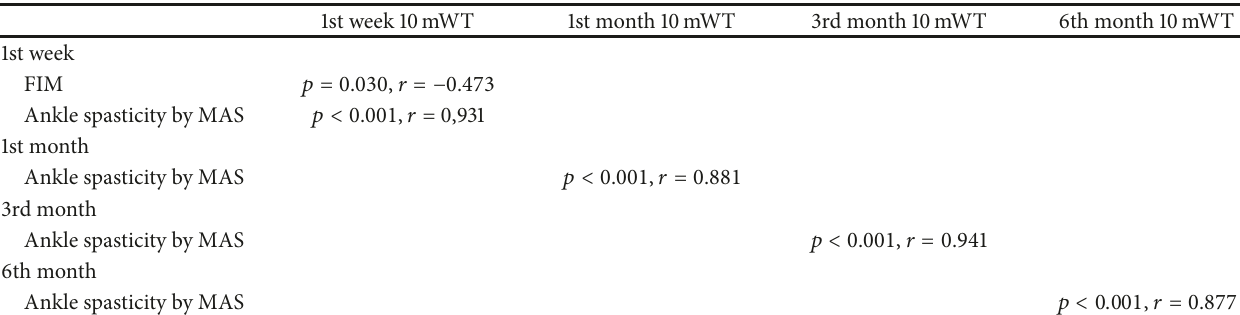
Table 3: Correlations between 10mWT in the intervention